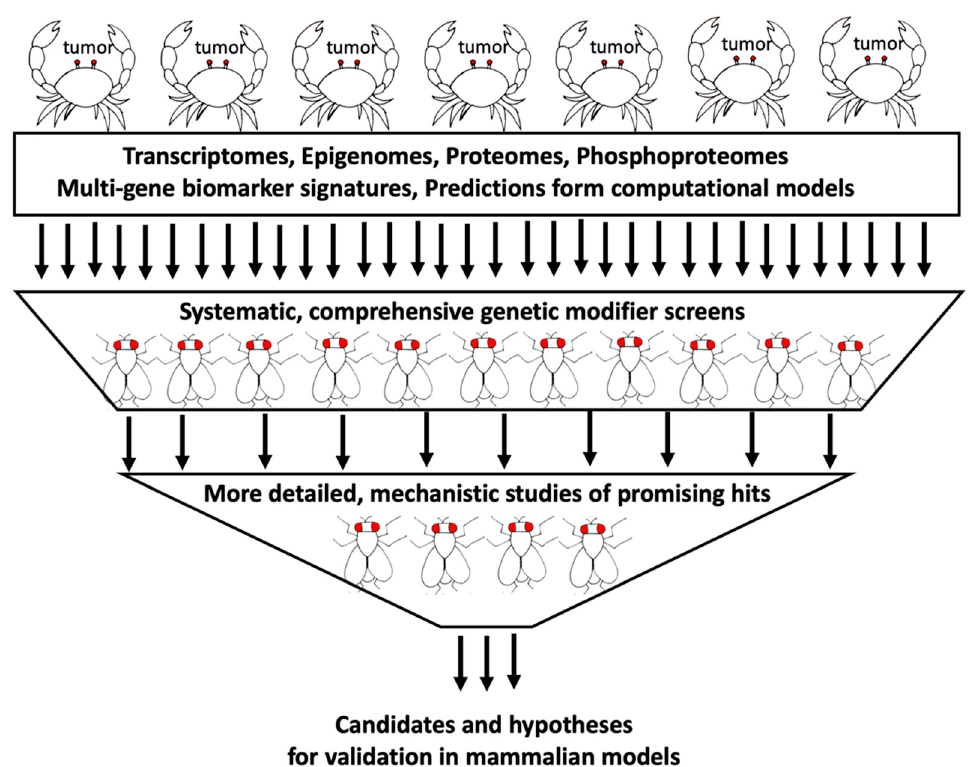
Figure 2. Strategy for functional exploration of different types of big cancer data. Comprehensive in vivo genetic modifier screens using tumor genome-based Drosophila models are performed to test functional relevance of gene expression changes, other alterations, and predictions from computational models. Validated hits are further explored in Drosophila to obtain insights into their mechanisms of action. This approach leverages genetic tools and practical advantages of flies in large-scale, exploratory studies to prioritize variants and establish more refined hypotheses to be tested in vertebrate models.